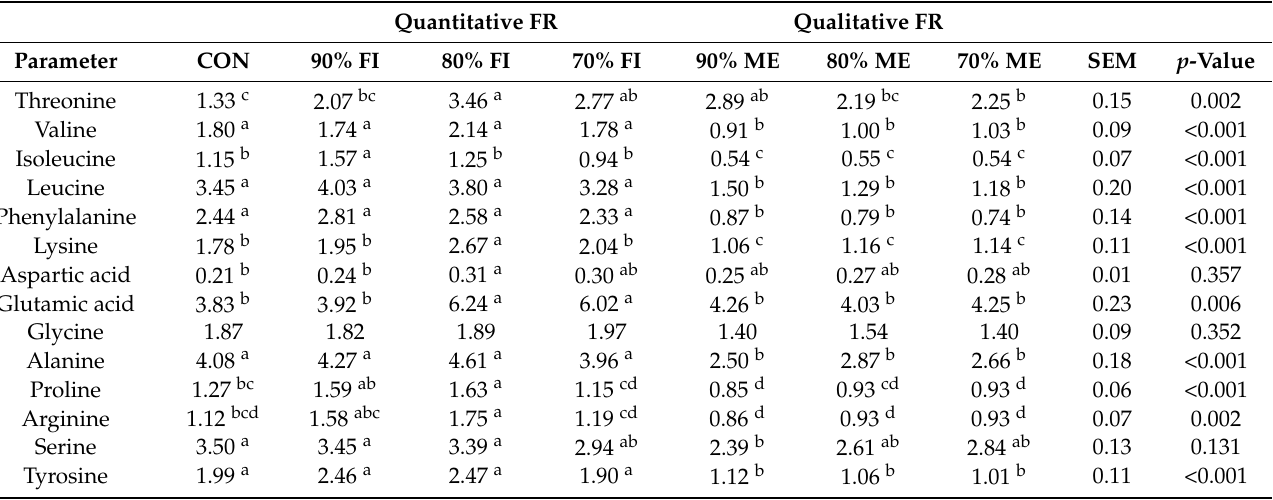
Table 8. Effects of feed restriction (FR) on the contents of free amino acid in the muscle of Bearded chickens